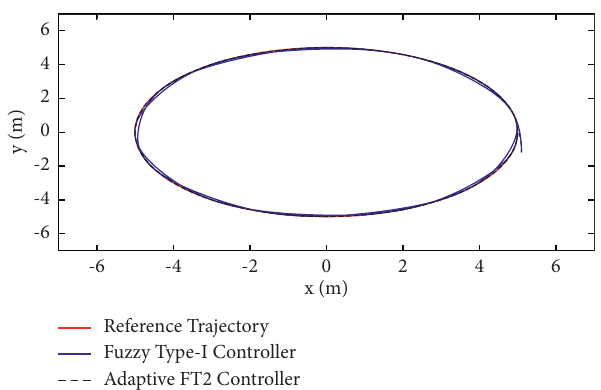
Figure 3: The output trajectory of adaptive interval fuzzy type-II and T-S fuzzy type-I controller.